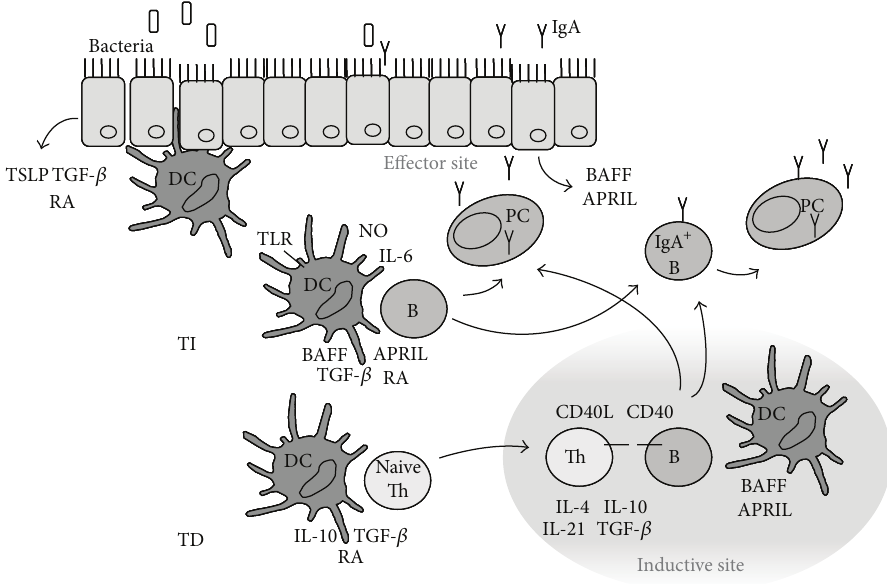
Figure 2: After conditioning by tissue-derived factors and TLR ligands, DCs activate T cells which provide for costimulatory signals (CD40- CD40L) and specific cytokines (TD), or DCs provide for alternative costimulatory signals, like BAFF and APRIL (TI) to initiate class switch recombination and expression of IgA by the mature B cells (IgA + B cell). From the inductive site, the IgA + -B cells will migrate to the draining effector sites, where, in response to additional signals, they become plasma cells (PCs) and start to secrete IgA.